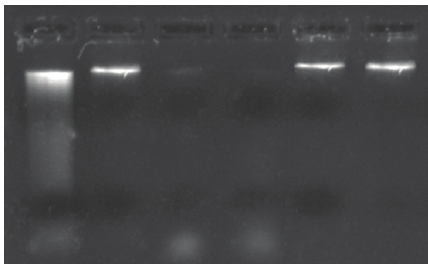
Figure 3:Agarosegel electrophoreticprofile of DNAextractedfrom the oil samples under investigation. From the left to the right: virgin olive oil from “A” oil production trial; virgin olive oil from “B” oil production trial; crude olive-pomace oil from “A” oil production trial; crude olive-pomace oil from “B” oil production trial; 50ng 𝜆 - DNA ladder; 100ng 𝜆 -DNA